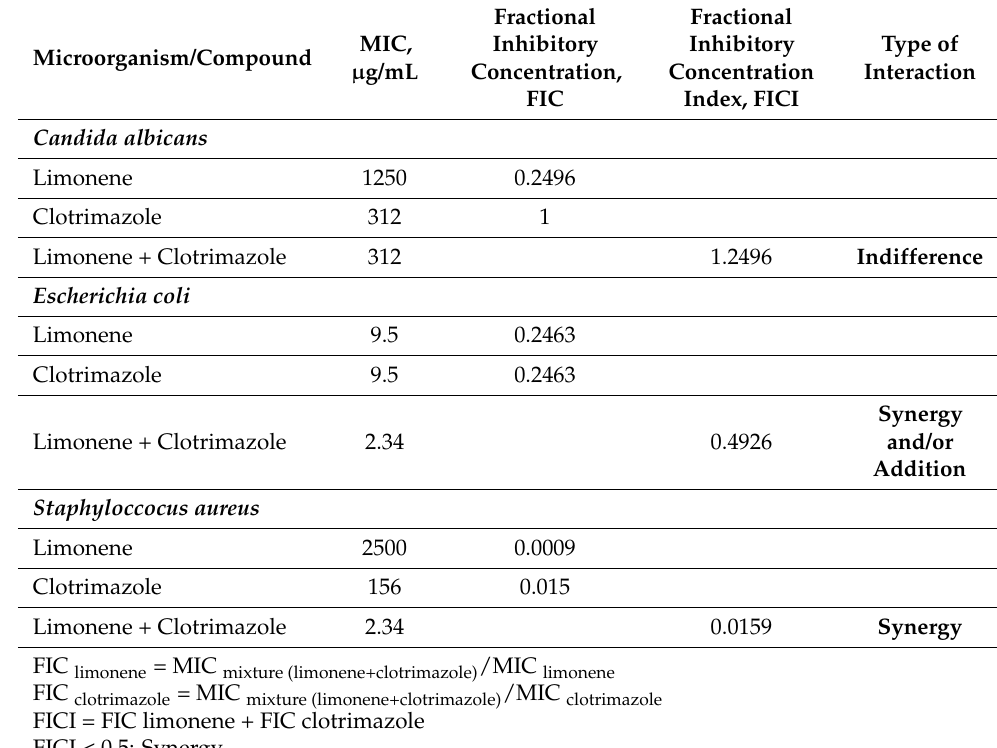
Table 10. Evaluation of the effect of clotrimazole and limonene on C. albicans , E. coli. , and S. aureus .